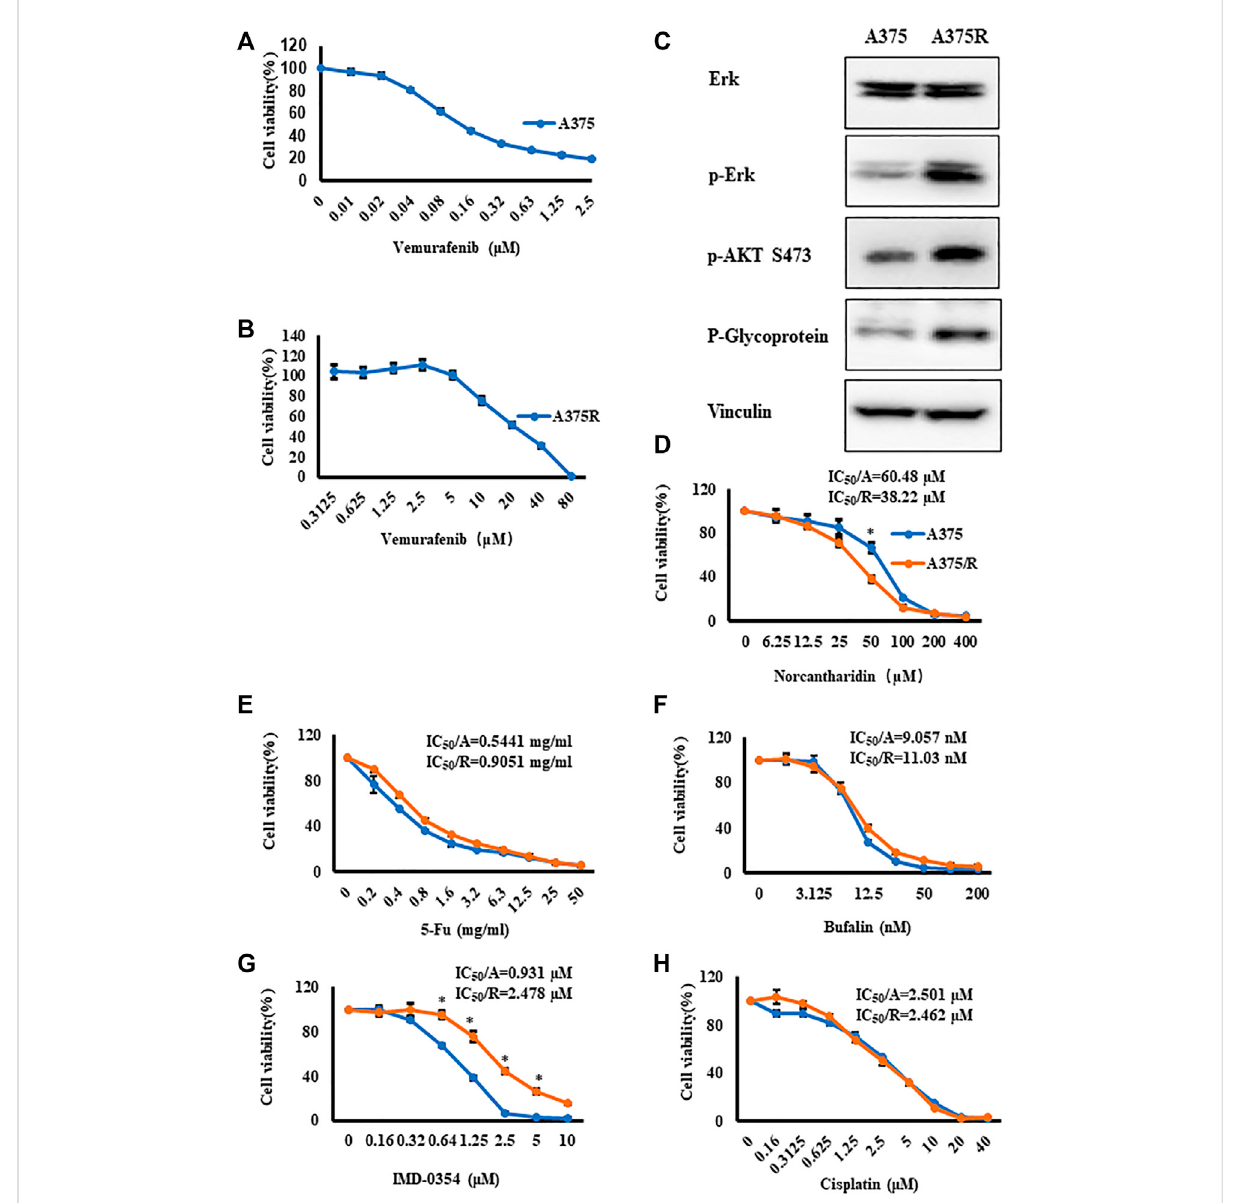
FIGURE 1 Vem-resistant melanoma cells (A375R) weregenerated, and NCTDdisplayed potenteffect on A375R. (A,B) A375 (A) andA375R (B) weretreated with indicated concentrations of Vem for 48 h, cell viability was measured by CCK8 assays. (C) Erk, p-Erk, p-AKT S473, and P-glycoprotein in A375 and A375R were detected by Western blot analysis. (D – H) Cisplatin (D) , 5-Fu (E) , bufalin (F) , IMD-0354 (G) , and NCTD (H) were cultured with A375andA375Rfor48 h,andcellviabilitywasmeasuredbyCCK8assays.Datawereshownasmean±SDfromthreeindependentexperiments, p p <